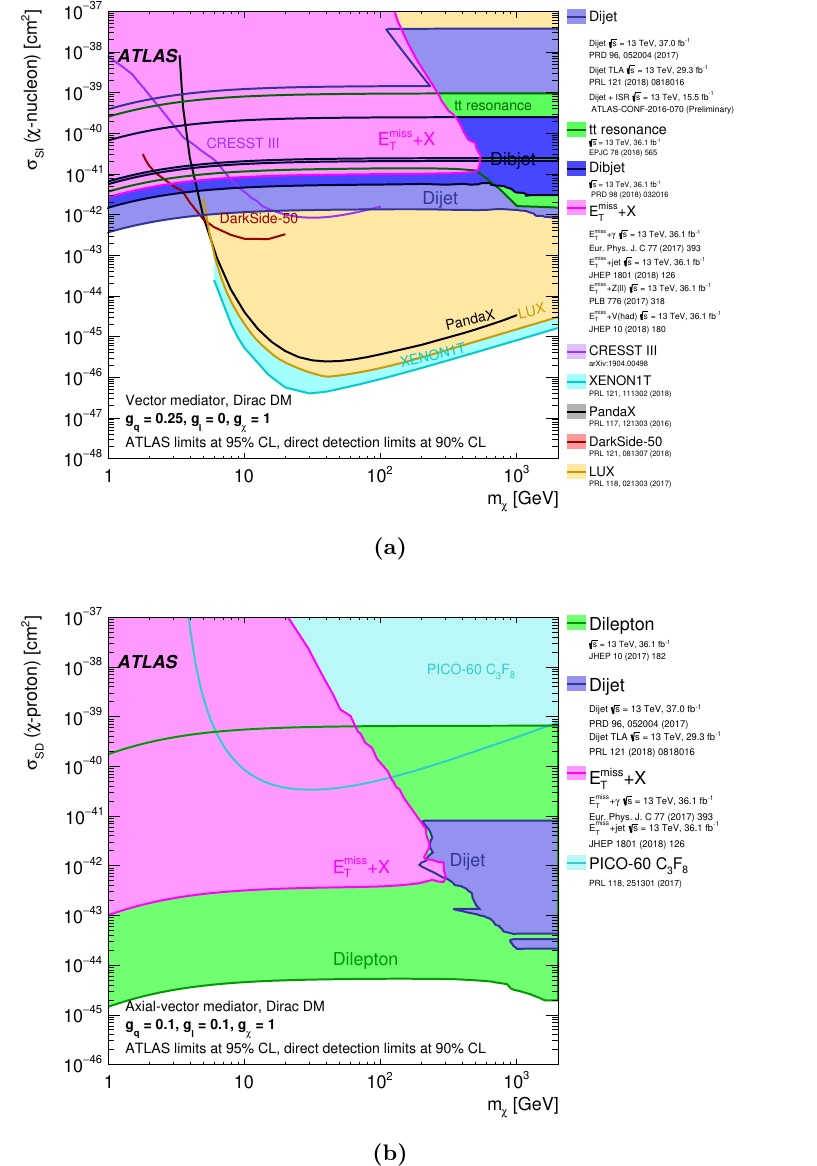
Figure 13. A comparison of the inferred limits with the constraints from direct detection experi- ments on (a) the spin-dependent WIMP-proton scattering cross-section in the context of the vector leptophobic model and (b) the spin-independent WIMP-nucleon scattering cross-section in the con- text of the axial-vector leptophilic model. The results from this analysis, excluding the region inside or to the left of the contour, are compared with limits from direct detection experiments. ATLAS limits are shown at 95% CL and direct detection limits at 90% CL. ATLAS searches and direct detection experiments exclude the shaded areas. Exclusions beyond the canvas are not implied for the ATLAS results. The dijet and E miss + X exclusion regions represent the union of exclusions T from all analyses of that type.